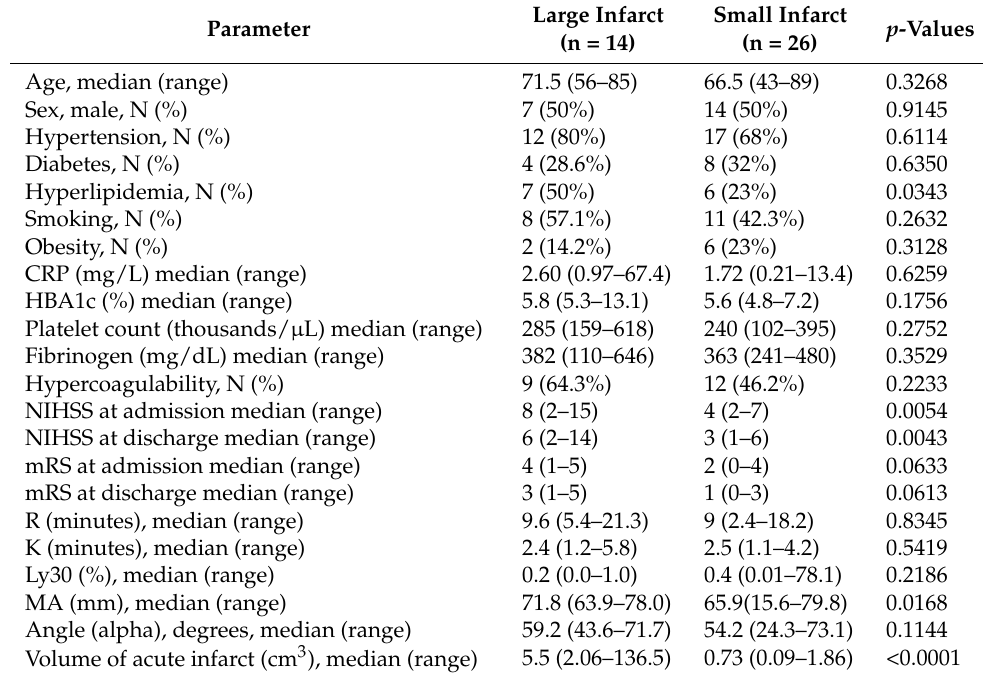
Table 2. Comparison of subpopulations with large (>2 cm 3 ) and small (<2 cm 3 ) acute ischemic infarct.